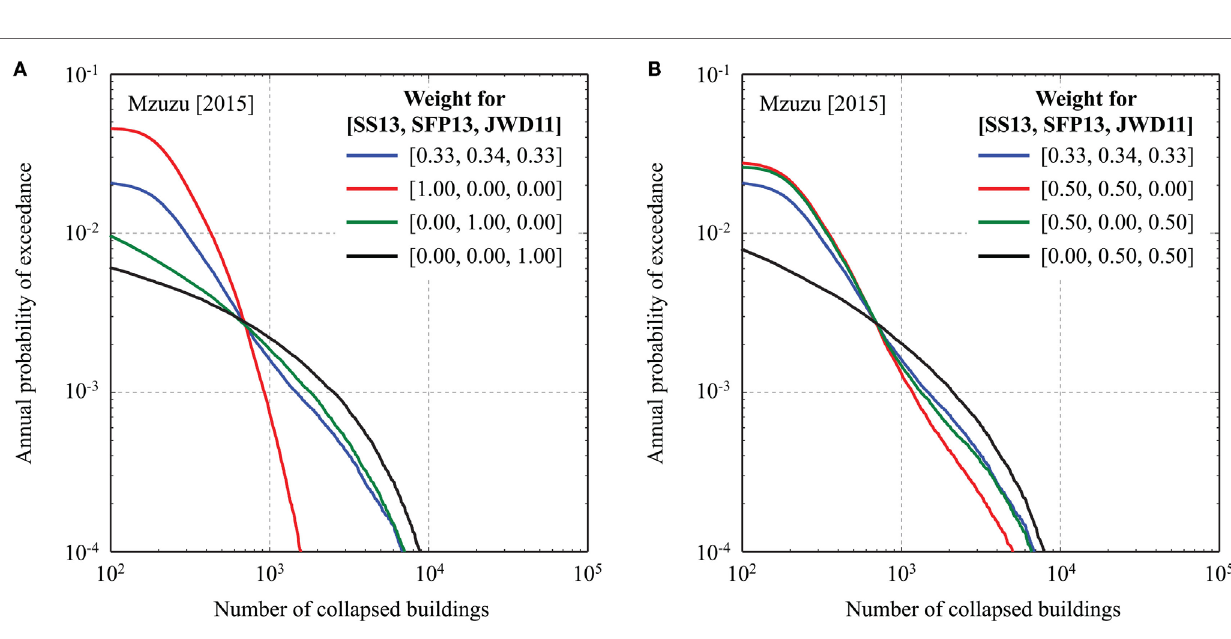
FigUre 14 | (a) Effects of vulnerability models (equal-weight model versus individual models) on building-collapse curves for Mzuzu. (B) Effects of vulnerability models (equal-weight model versus combined models consisting of two individual models) on building-collapse curves for Mzuzu. In the figure legend, SS13 represents the So-Spence model, SPF13 represents the Spence–Foulser-Piggott model, and JWD11 represents the Jaiswal et al. model.